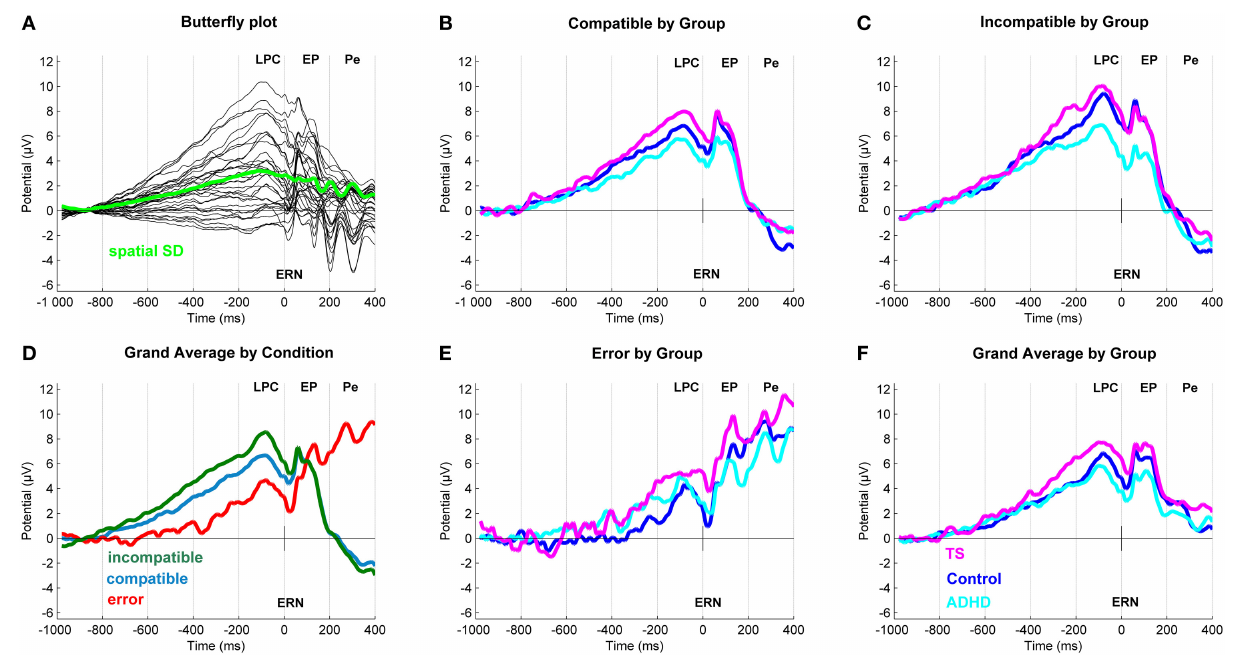
FIGURE 3 | Response-locked event-related potentials (ERP). (A) Butterfly plot. Topographical distribution of the Late Positive Component across outcomes. (D) Grand average ERP by Outcome at a central region of interest for compatible (blue), incompatible (green) and erroneous (red) trials. (B,C,E) Linked mastoid referenced grand average ERPs at a central region of interest with a Late Positive Component ( − 80ms) and early positivity (60ms). In erroneous trials (bottom middle) also seen an ERN (20ms) and a Pe (268ms). (F) Grand average ERP by Group. Group differences for Tourette syndrome (TS) (pink), attention-deficit/hyperactivity disorder (ADHD) (turquoise) and control children (blue) at a central region of